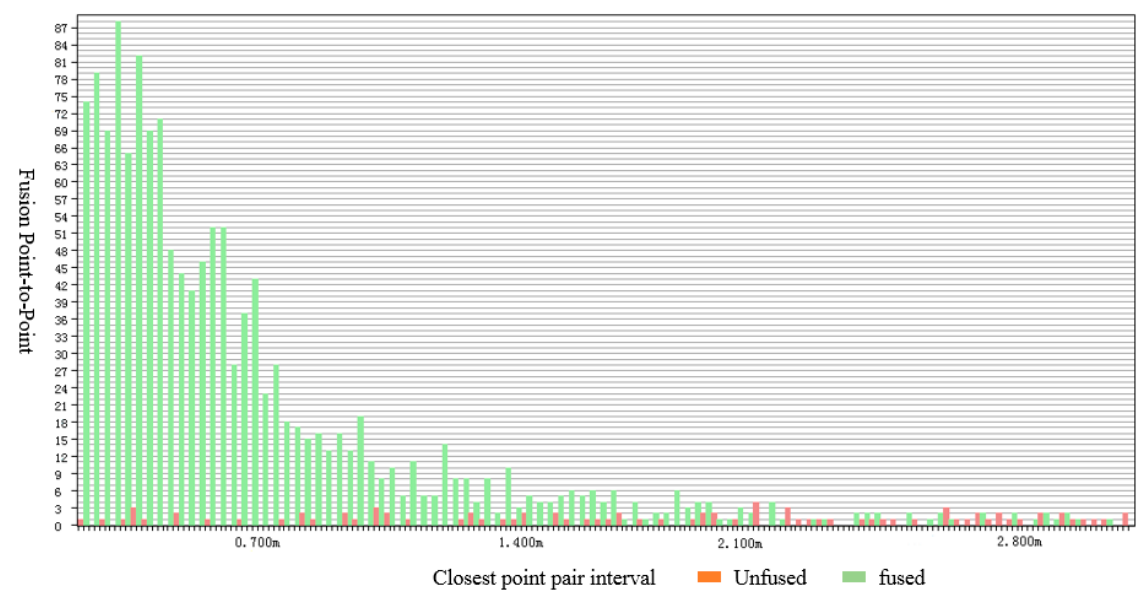
Figure 10. Histogram of nearest point pair of improved ICP algorithm.